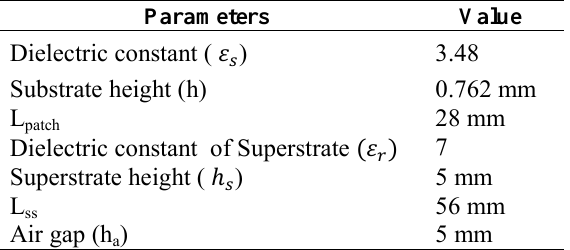
Figure 3. Proposed antenna structure for Beam diversity. Table 1: Physical dimensions of the suggested antenna.